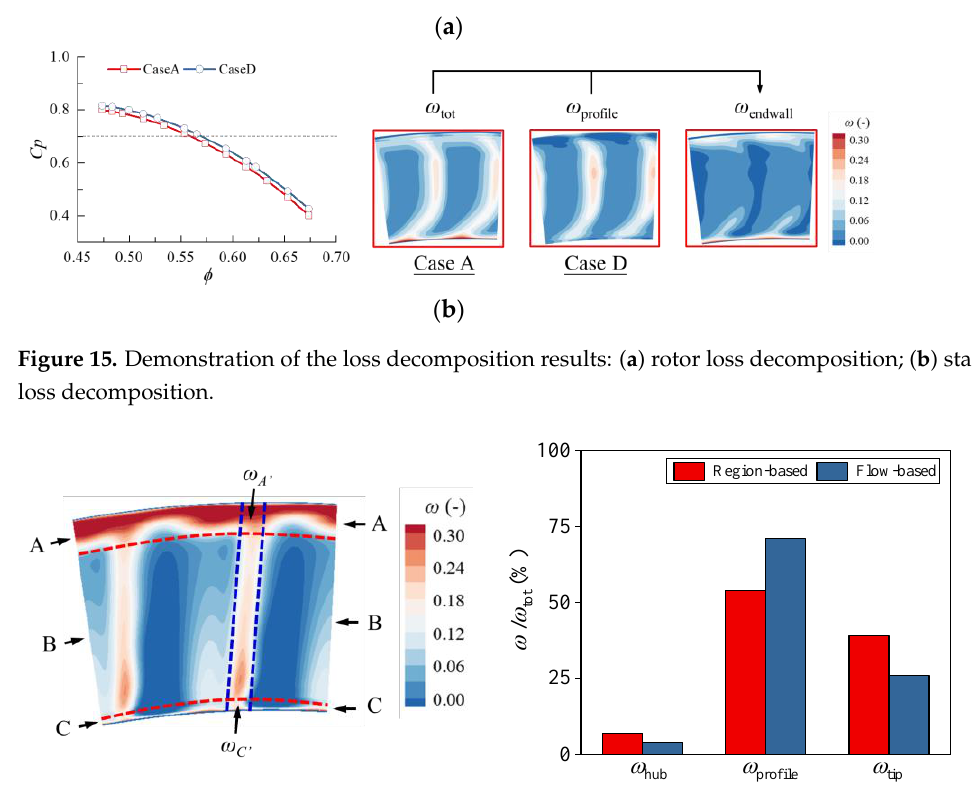
Figure 16. The comparison between the different loss decomposition methods.